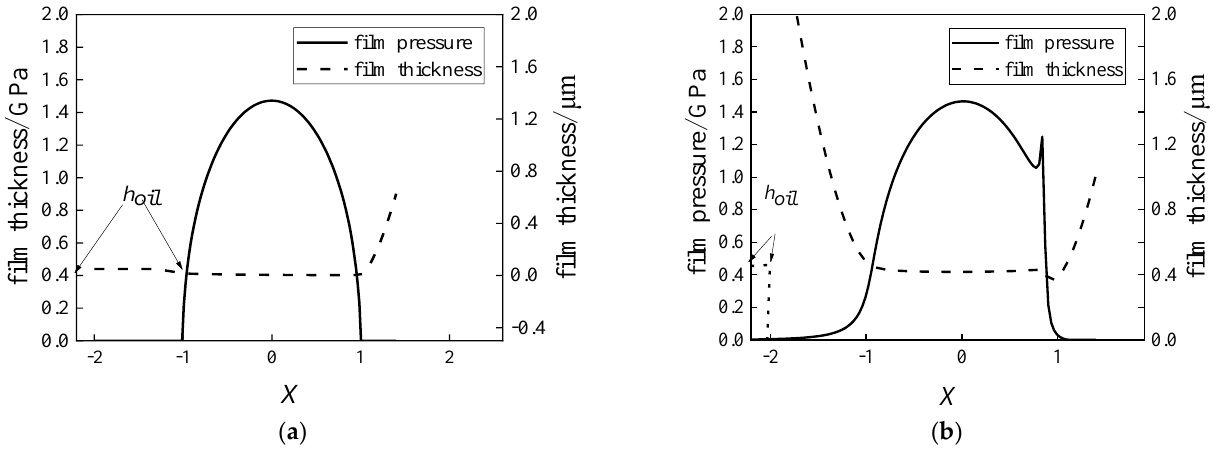
Figure 9. Distribution of oil film pressure and film thickness at different −𝑋 𝑖𝑛 values. ( a ) −𝑋 𝑖𝑛 = 1.01 ; ( b ) −𝑋 𝑖𝑛 = 2.75 .